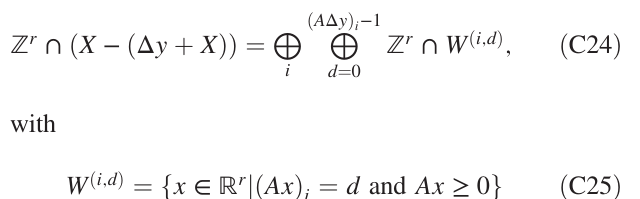
¯ W ð i; 0 Þ are represented by red dots. (c) W ð 4 ; 1 Þ in the y 3 ¼ 1 plane. The ¯ V ð 4 ; 1 Þ are represented by the hollow circle, the points ¯ W ð 4 ; 1 Þ are represented by red